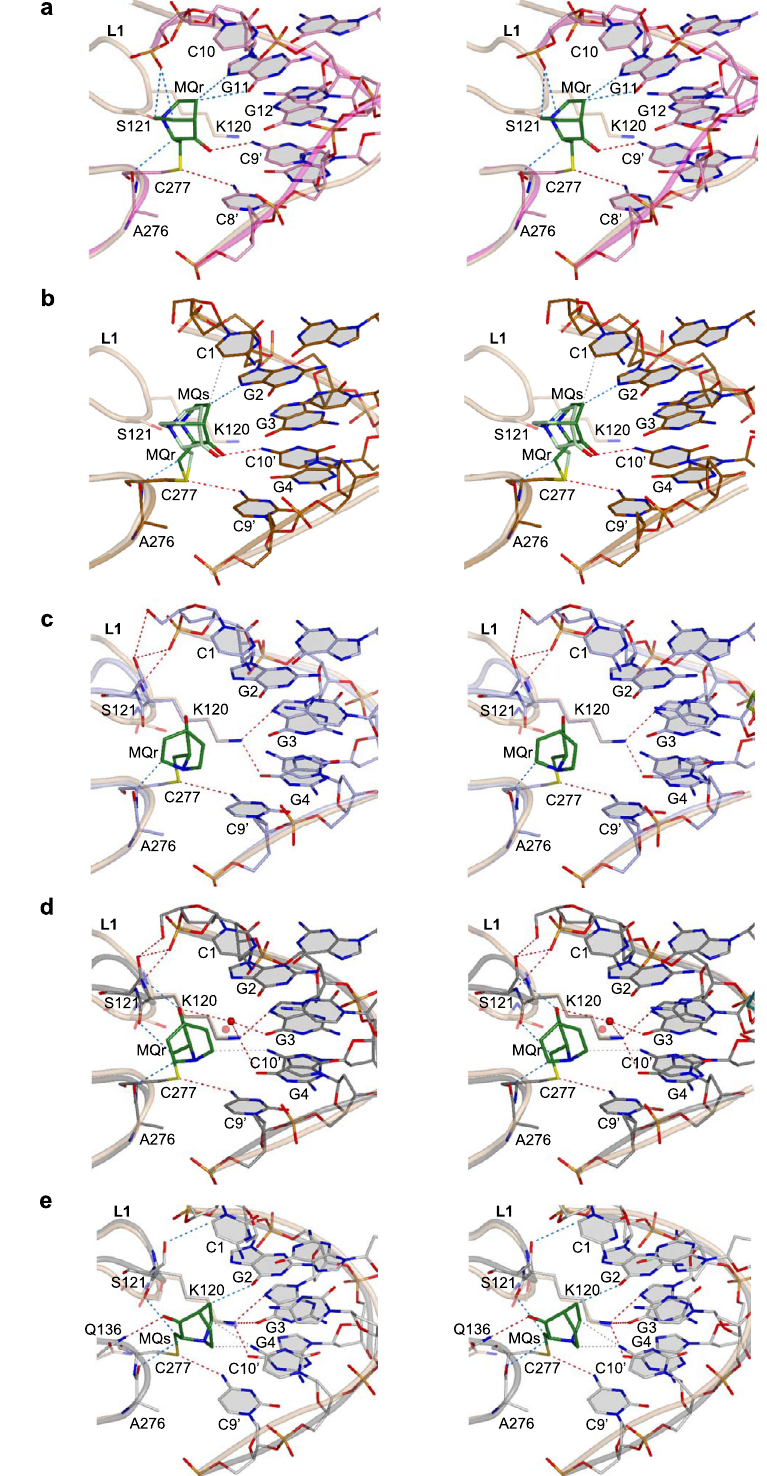
loop. A local conformational change in L1, relative to that of the MQ-free complexes, leads to different stabilizing contacts between S121 and the backbone of the 5 ′ -end nucleotides without affecting the nearby K120 interactions with G3 and G4 bases (Fig. 9c – e). In these structures, no direct MQ-mediated hydrogen bonds with the DNA bases are observed, except for a water- mediated hydrogen bond between the MQ carbonyl oxygen and